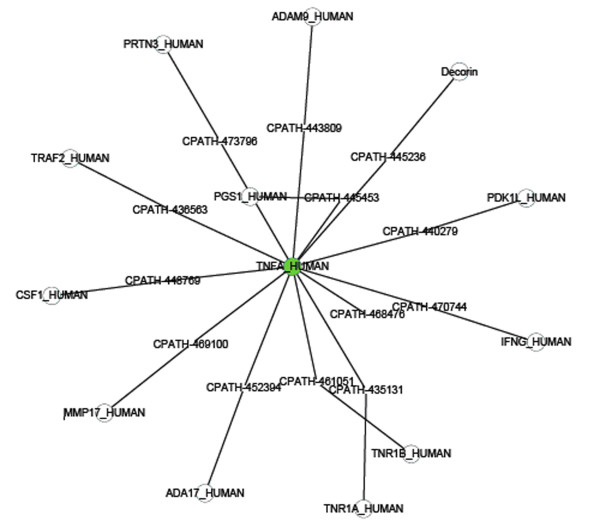
Regulatory sub-network of differentially expressed TNF of rhein through network pharmacology.